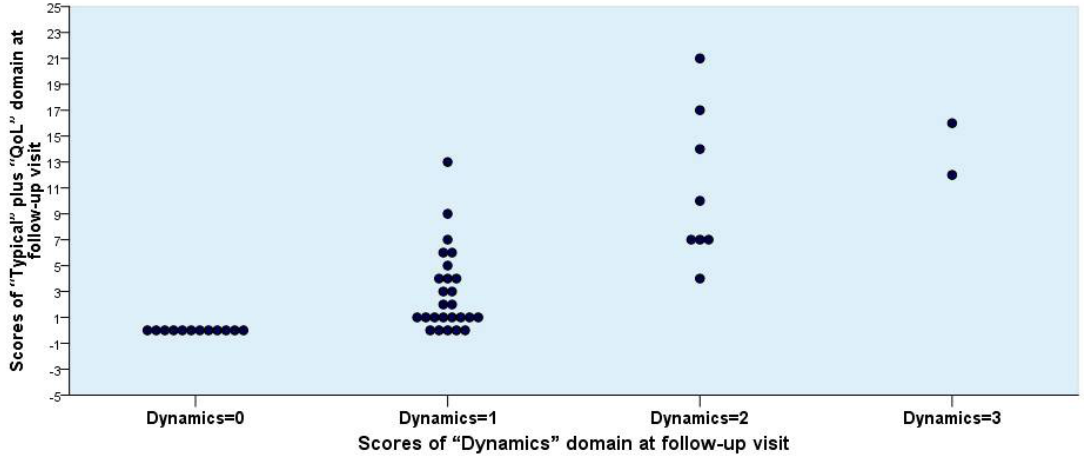
Figure 4. Individual scores for “Typical” plus “Quality of Life (QoL)” versus “Dynamics” domain obtained from 48 female patients at the follow-up visit.